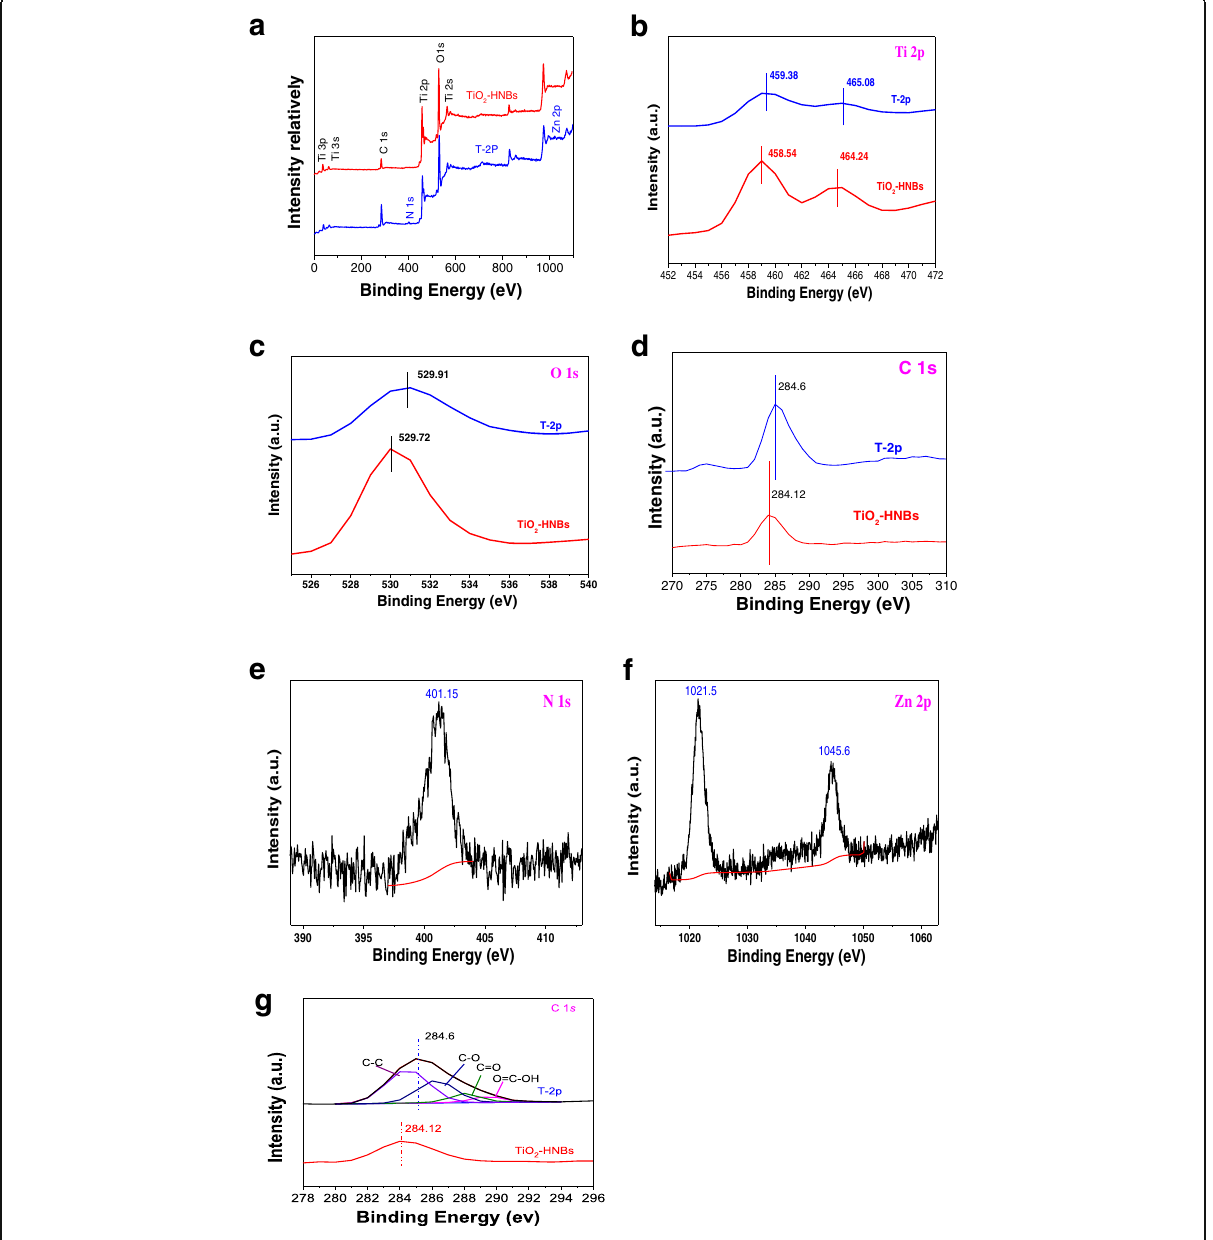
Fig. 7 a The full spectra of all kinds of elements in sample TiO 2 -HNBs and T-2p; b the high-resolution Ti 2p XPS signals of TiO 2 -HNBs and T-2p; c the O1s XPS signals of TiO 2 -HNBs and T-2p; d the C1s O1s XPS signals of TiO 2 -HNBs and T-2p; e the N1s XPS signals of T-2p; f the Zn 2p XPS signals of T-2p; g the C XPS-peak-differentation-imitating